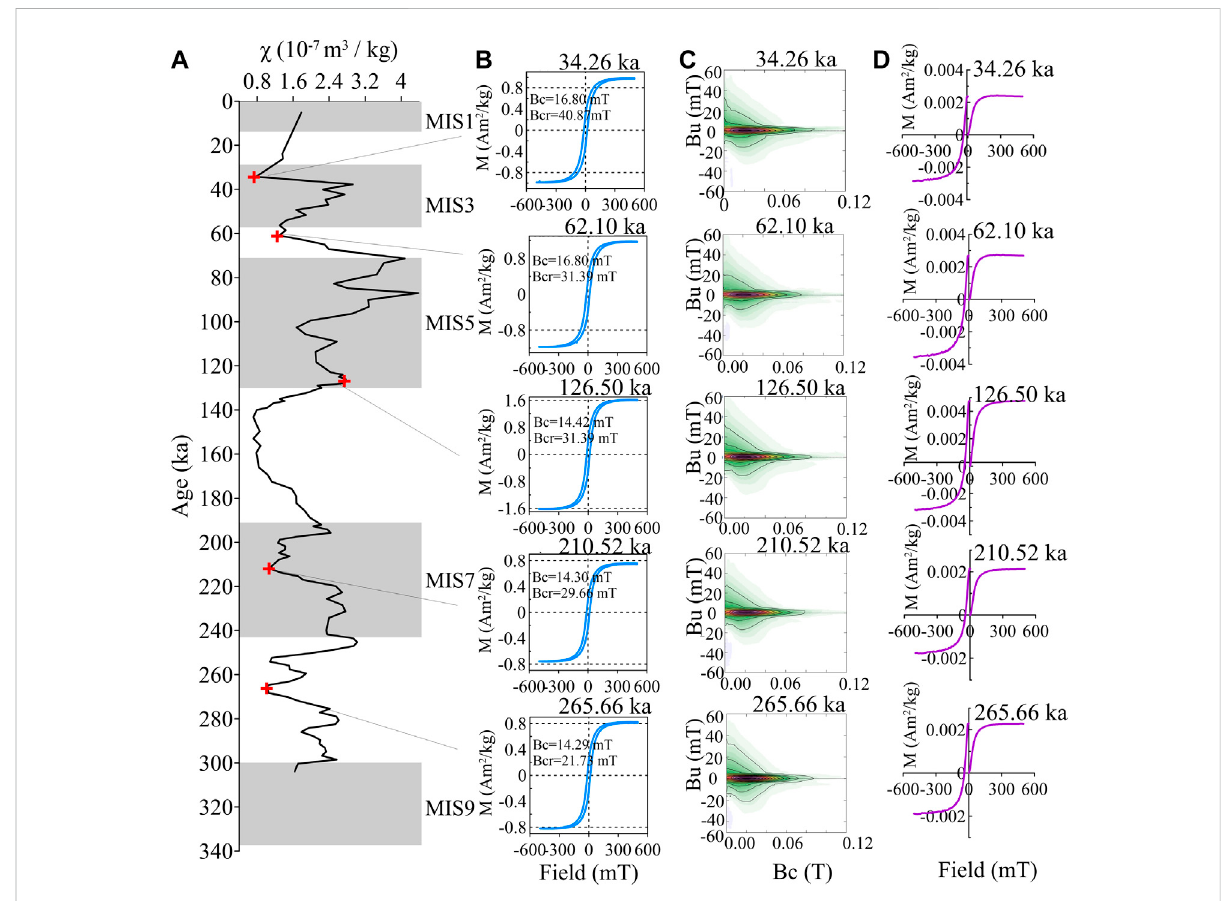
FIGURE 5 Rock magnetism results from the H10 core. (A) Variations in mass normalized magnetic susceptibility ( χ ); (B) hysteresis loops; (C) FORC plots; (D) IRM acquisition curves and RFD curves of representative